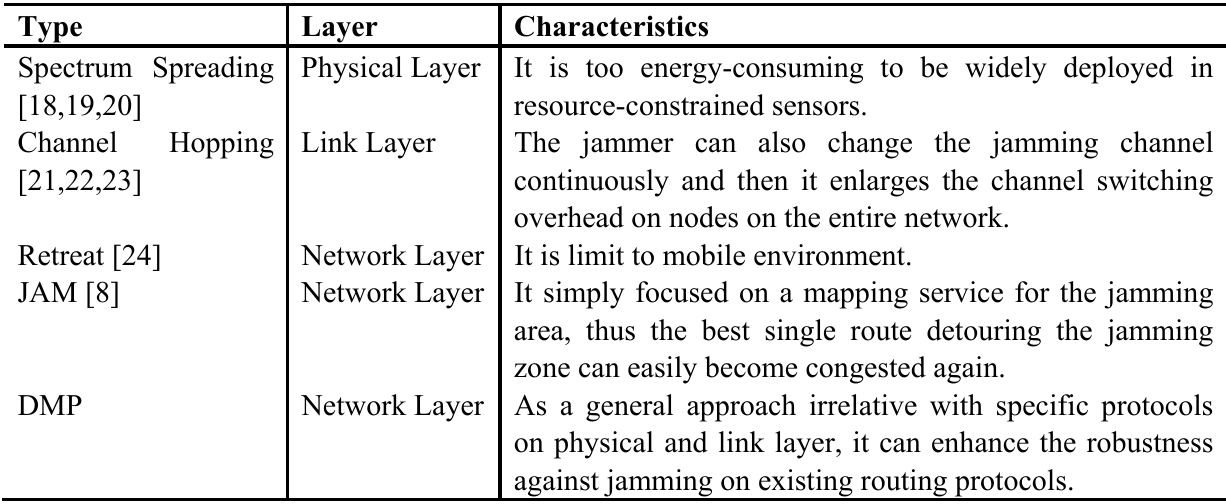
Table 1. Comparison of DMP with relative evasion